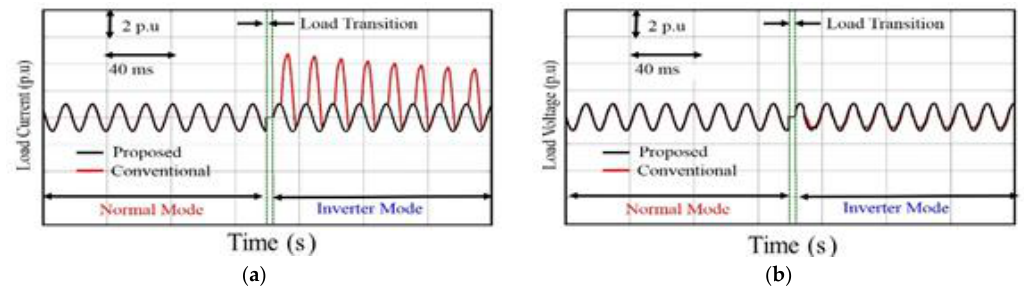
Figure 24. ( a ) Load current; and ( b ) load voltage for the conventional and proposed single-phase offline UPS topologies when the inverter voltage is injected at 360°.